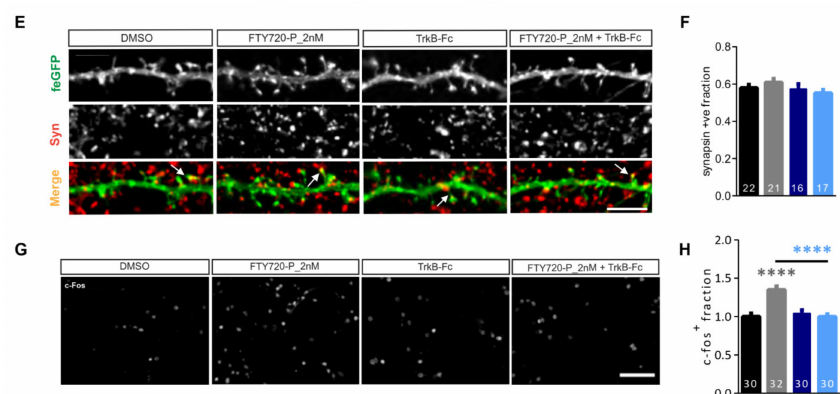
Figure 2. Fingolimod-phosphate (FTY720-P) regulates neuronal architecture in a BDNF-dependent manner. ( A ) Representative Neurolucida tracings, used to perform the Sholl analysis of dendritic complexity for feGFP expressing neurons treated for 24h with: DMSO (black), 2nM FTY720-P (gray), DMSO + TrkBFc (dark blue) and 2nM FTY720-P + TrkBFc (light blue). Scale bar: 100 µ m. ( B ) Sholl analysis displayed as number of dendritic intersections against distance from the cell body for DMSO (black), 2nM FTY720-P (gray), DMSO + TrkBFc (dark blue) and 2nM FTY720-P + TrkBFc (light blue) and ( C ) total dendritic complexity of all treatment groups. F value in ( B ) refers to comparison between all the 4 treatment groups. ( D ) Dendritic spine densities for DMSO (black), 2nM FTY720-P (gray), DMSO + TrkBFc (dark blue) and 2nM FTY720-P + TrkBFc (light blue) calculated using segments of secondary dendritic branches as shown in ( E ) feGFP panel. The Syn panel displays the corresponding staining of the pre-synaptic marker SynapsinI / II and the merge panel shows the images with overlapping SynapsinI / II puncta (red, pre-synapse) to its matching feGFP dendrite segment (green, post-synapse). The arrows point to coinciding puncta, indicative of mature synapse between the post and pre-synaptic compartments. Scale bar: 5 µ m. ( F ) The graph compares the fraction of SynapsinI / II positive feGFP labelled spines for DMSO (black), 2nM FTY720-P (gray), DMSO + TrkBFc (dark blue) and 2nM FTY720-P + TrkBFc (light blue). ( G ) Representative fields of view (FOV) of the DMSO, 2nM FTY720-P, DMSO + TrkBFc and 2nM FTY720-P + TrkBFc treated hippocampal cultures stained for c-fo s . Scale bar: 100 µ m. ( H ) Quantification of the proportion of c-Fos expressing neurons represented as normalized fraction for DMSO (black), 2nM FTY720-P (gray), DMSO + TrkBFc (dark blue) and 2nM FTY720-P + TrkBFc (light blue) treated cultures. All graphs represent data as mean + SEM. Numbers in the bars show either total number of neurons or of FOV analyzed, obtained from ≥ 3 sets of independent experiments. Two-way ANOVA followed by Bonferroni post-hoc test was used in ( B ). For ( C , D , F ) and ( H ) one-way ANOVA with Bonferroni post-hoc was used. Denotations for significance are * p < 0.05, ** p < 0.01, **** p <